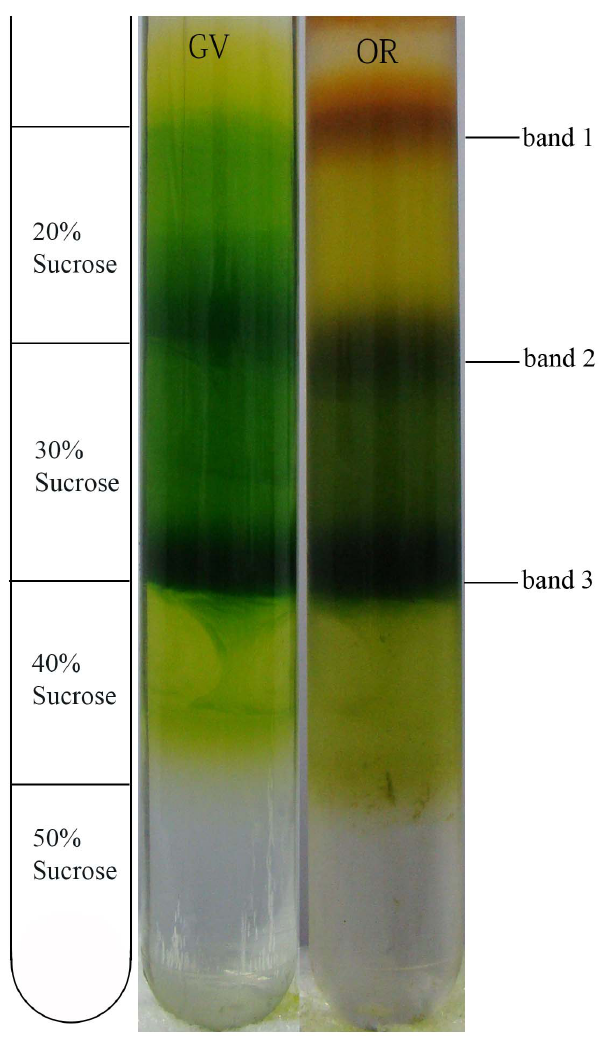
Figure 4. Bands of native thylakoid membrane formed during sucrose gradient ultracentrifugation. Crude thylakoid membrane pellet was subjected to discontinuous sucrose gradient (50, 40, 30, and 20% sucrose, w/v) ultracentrifugation at 105,000 g for thylakoid purification. Band 3 was the most abundant membranes stacked between 30 and 40% sucrose layers. Band 2 was fragmented thylakoid and band 1 contained some free pigments released during extraction. Compared to GV, a red band appeared in OR due to the astaxanthin esters released during extraction.